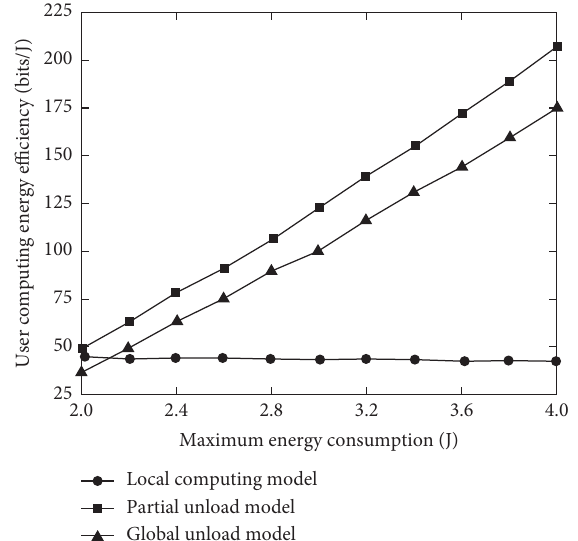
Figure 4: Relationship between calculated energy efficiency and maximum energy consumption of different loading models.